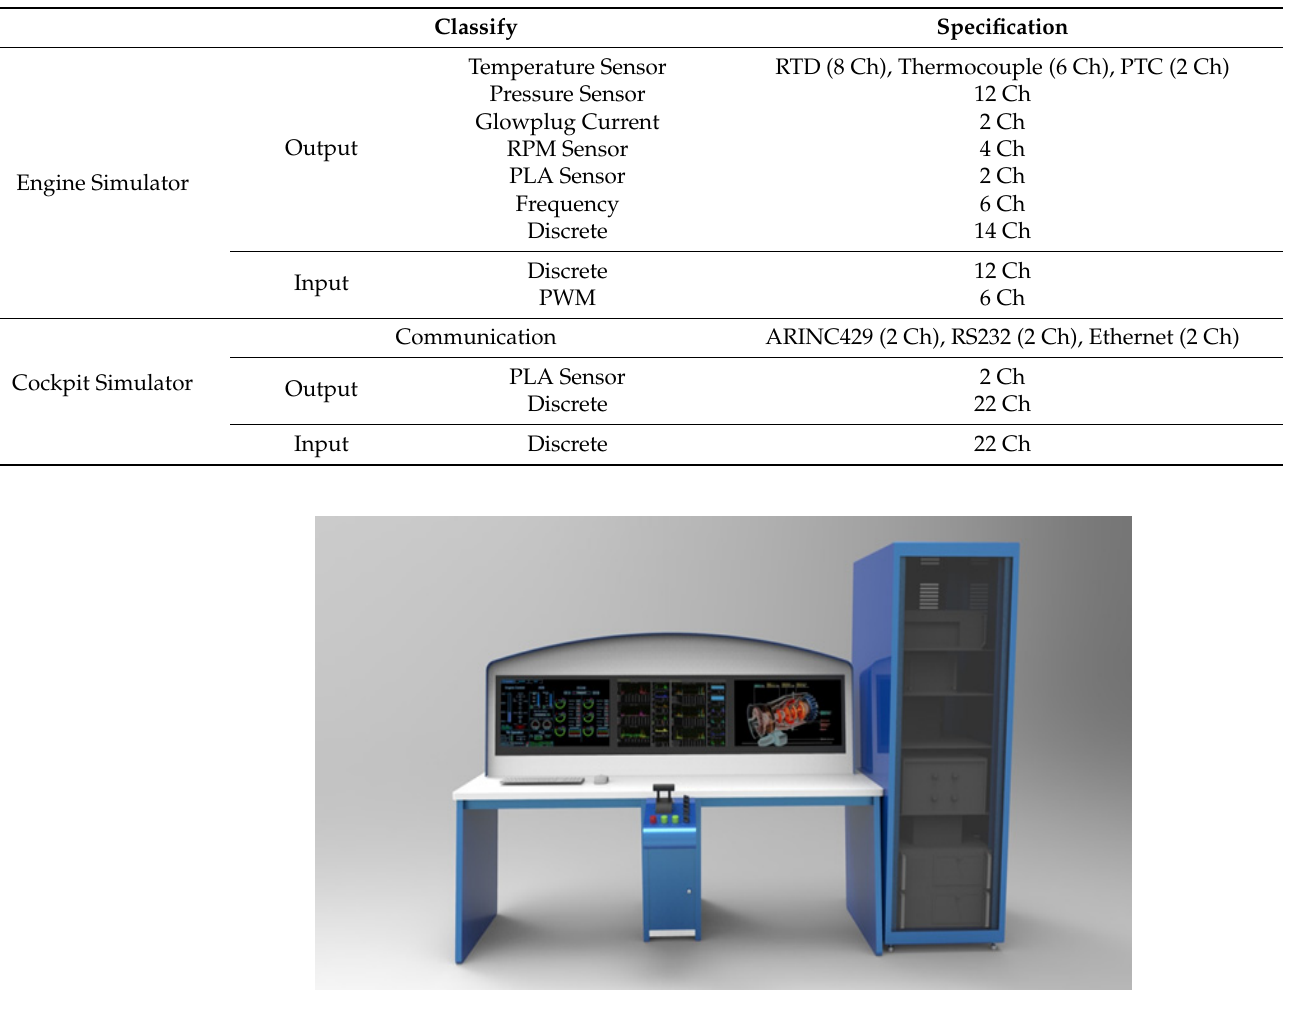
Figure 6. Conceptual diagram of developed test bench.